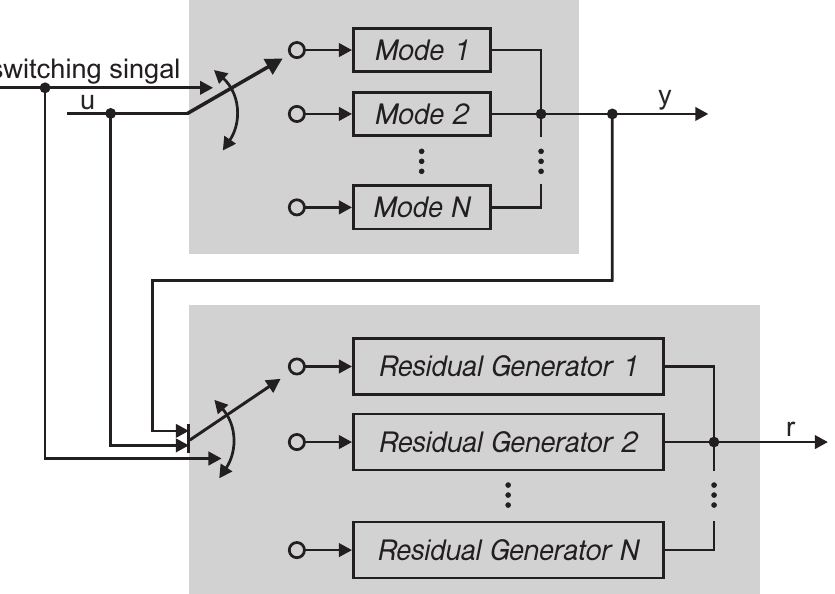
Figure 1. Schematic diagram of fault detection for switched systems with available switching